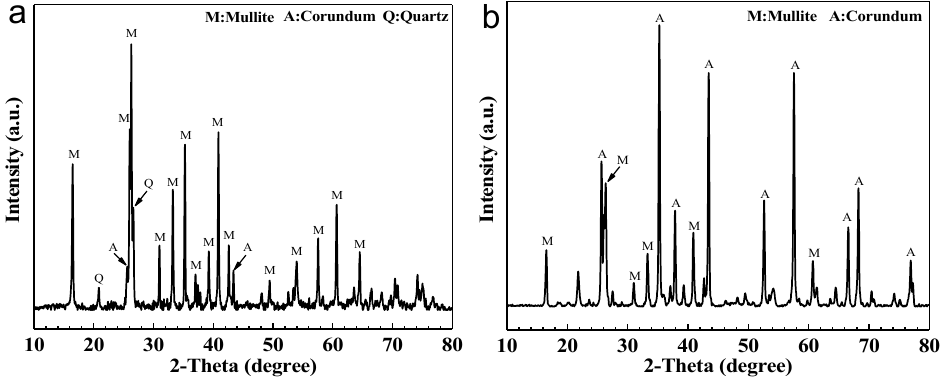
Figure 2. XRD patterns of fly ash ( a ) and bauxite ( b ).